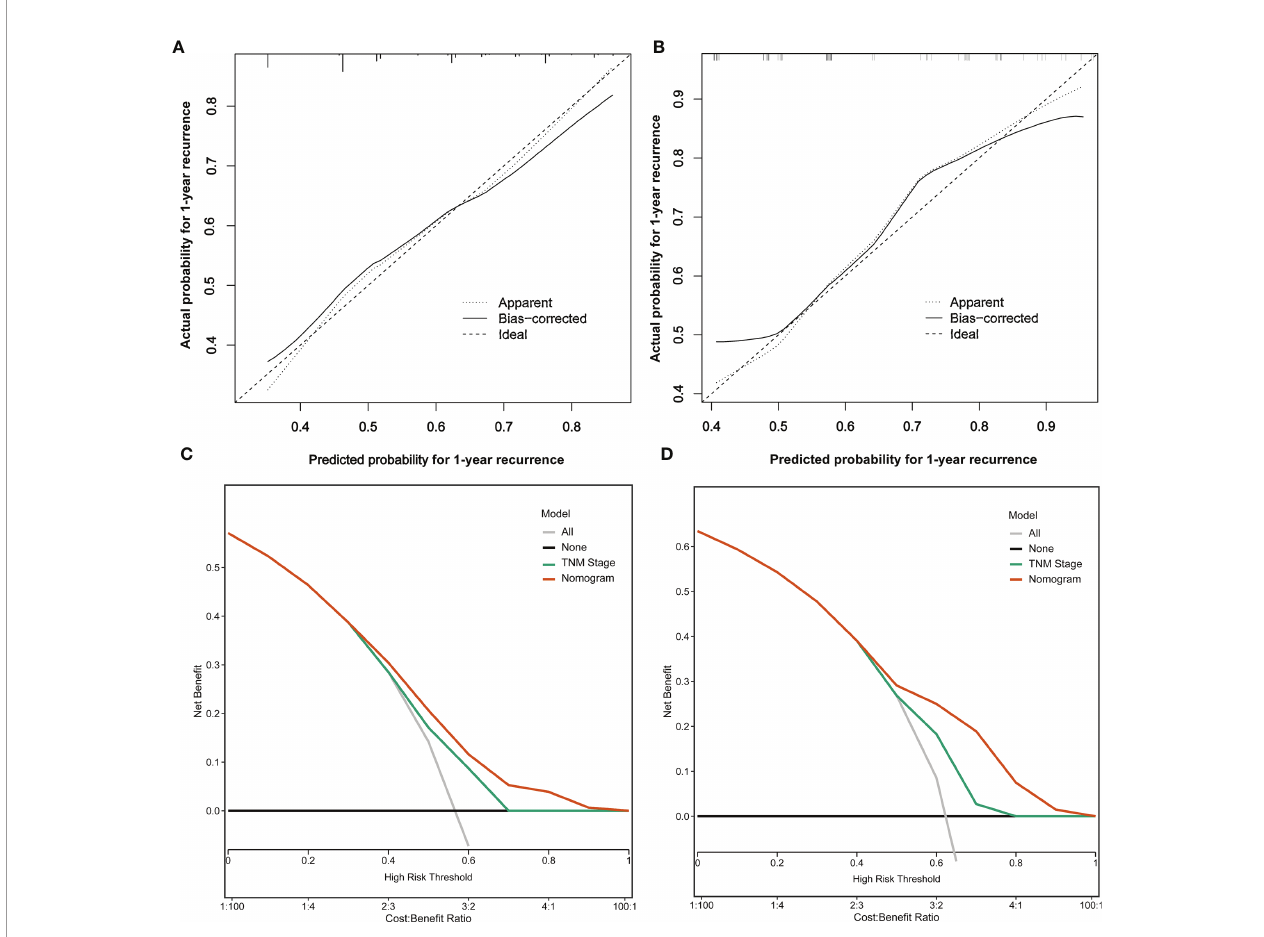
FIGURE 4 | Analysis of calibration plots and decision curves for the nomogram prediction model. (A) Calibration plot for the nomogram in the training set. (B) Calibration plot for the nomogram in the testing set. (C) Decision curve analysis for the nomogram in the training set. (D) Decision curve analysis for the RFS in the testing